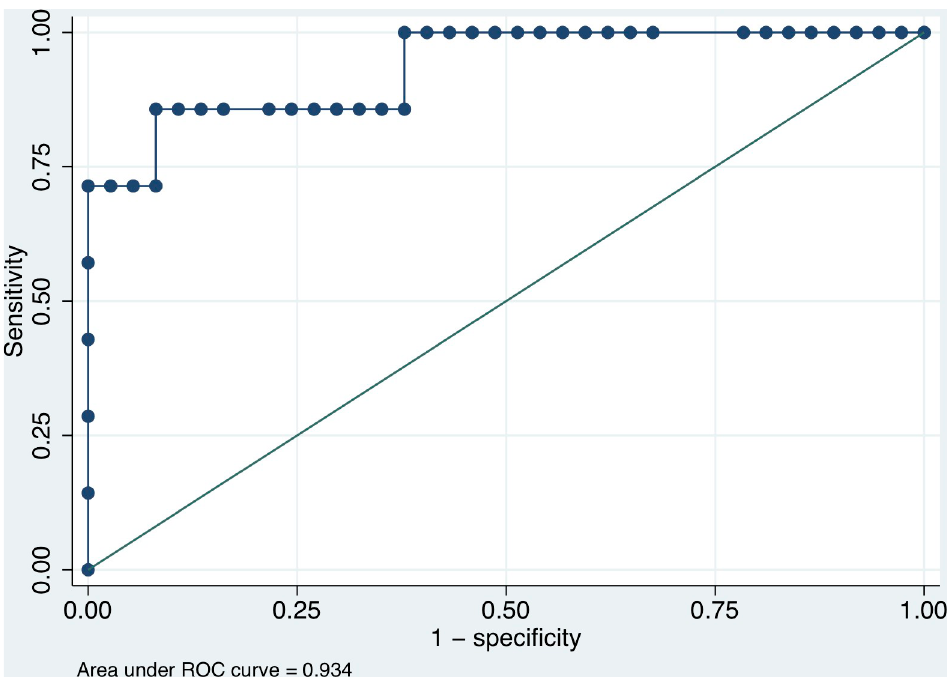
Fig 4. Receiver operating characteristic (ROC) curves for detecting hemoconcentration using a POC-Hb device compared with the traditional hematocrit criteria among dengue patients recruited at Ramathibodi Hospital and Chakri Naruebodindra Medical